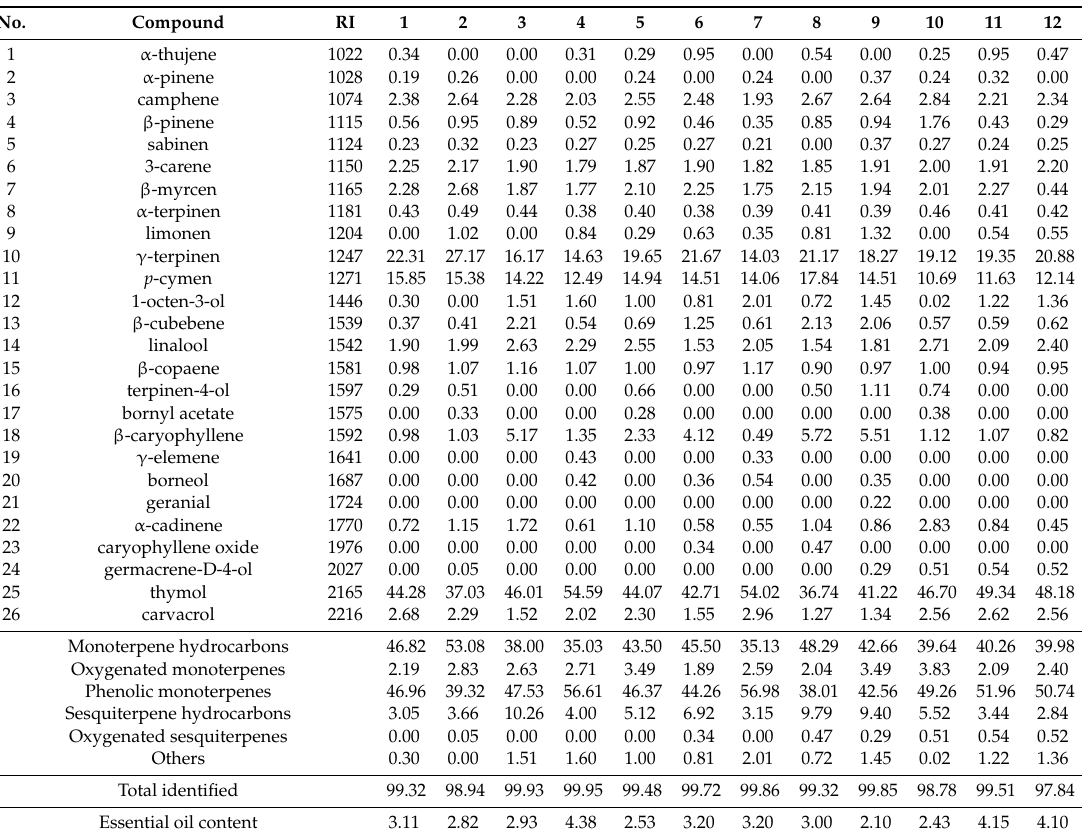
Table 5. The total content (g × 100 g − 1 ) and gas chromatographic composition (% peak area) of essential oil